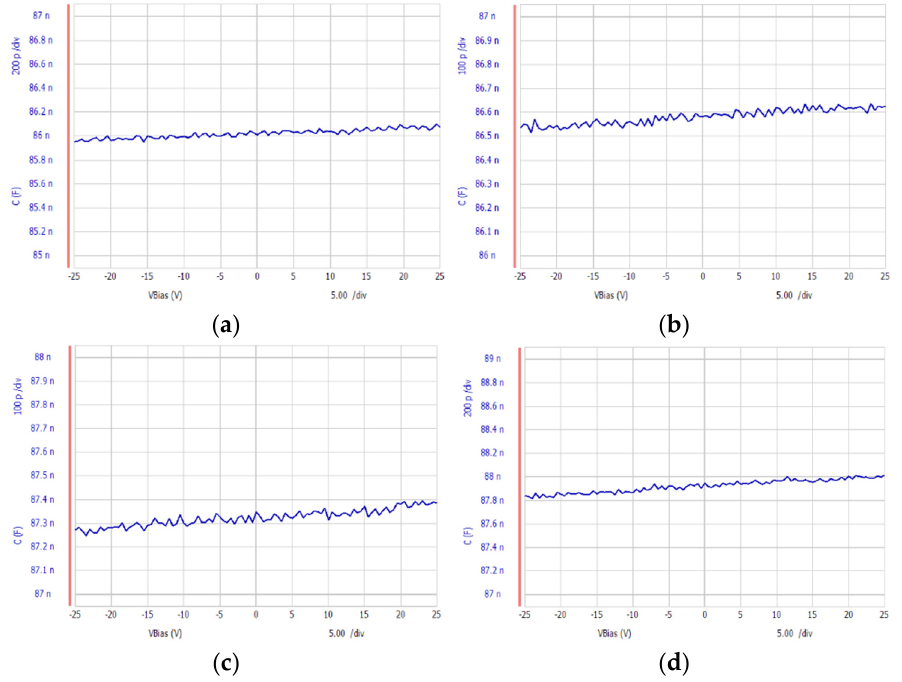
Figure 7. Capacitance vs. voltage at temperatures of ( a ) 40 ℃ , ( b ) 50 ℃ , ( c ) 60 ℃ , ( d ) 70 ℃. The difference in permittivity under an applied voltage of − 25 V versus the permittivity under an applied voltage of 25 V at 25 , 40, 50 , 60 , and 70 ℃ was 0.0092 × 10 − 11 , 0.0116 × 10 − 11 , 0.013 × 10 − 11 , 0.015 × 10 − 11 , and 0.021 × 10 − 11 F/m, respectively, as shown in Figure 8.